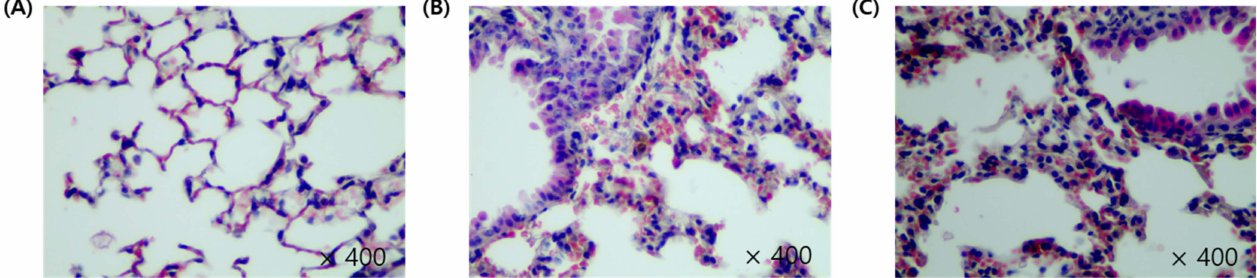
Figure 2. Histopathological analysis of the lungs in C57BL/6J mice. The lung sections were stained with haemotoxylin and eoxin(H&E), × 400. ( A ) The lung image of control (CON), ( B ) Positive control (PC), ( C ) and test (SS)